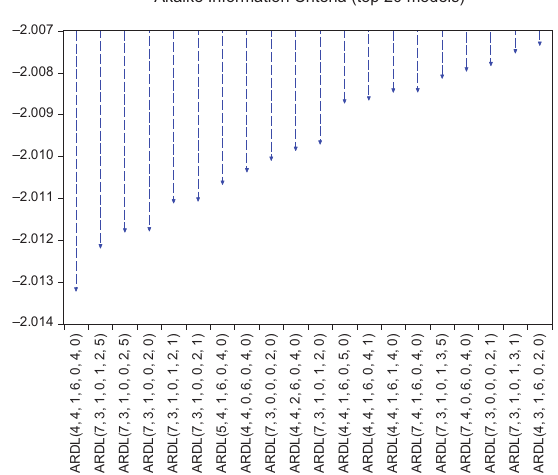
Figure 3. Selection of appropriate lag length for ARDL bounds test (source: own calculation of author) ARDL bounds test results for the determined (4,4,1,6,0,4,0) model are given in Table 7. F-statistic is greater than the upper limit critical value at the 1% significance level, and the alternative hypothesis (H1) is accepted. Table 7. ARDL bounds test results (source: own calculation of author) Critical values for the Critical values for the F-statistic a F-statistic Model F-statistics